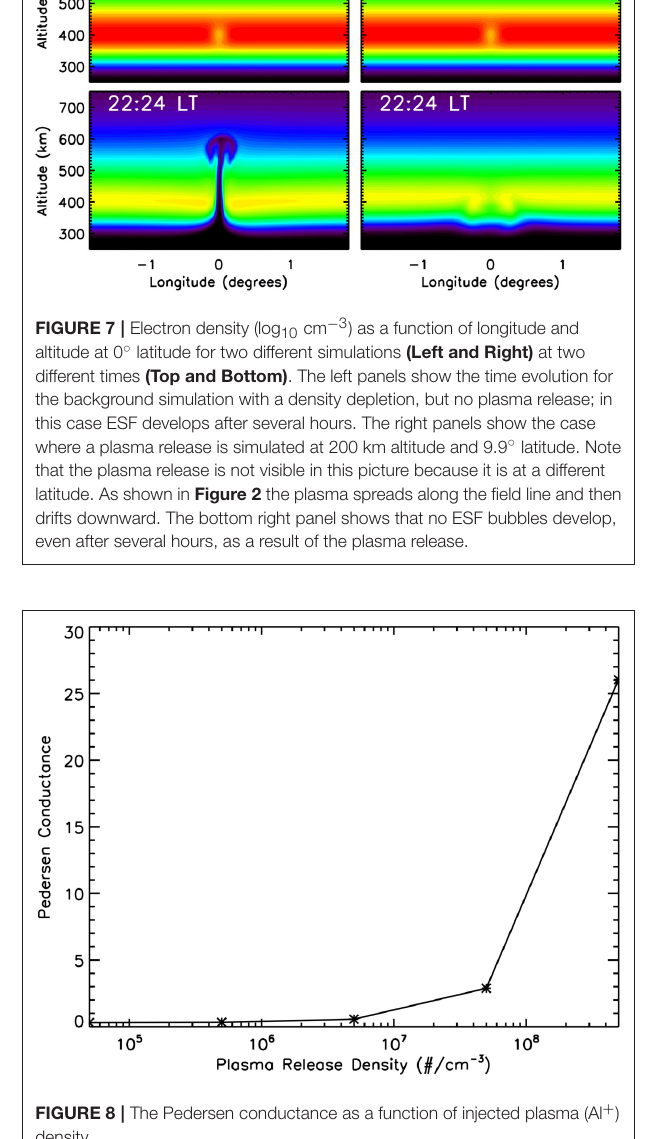
the bubble. In this case, the density depletion and the plasma release both covered 15 and 35 km in the longitude and latitude